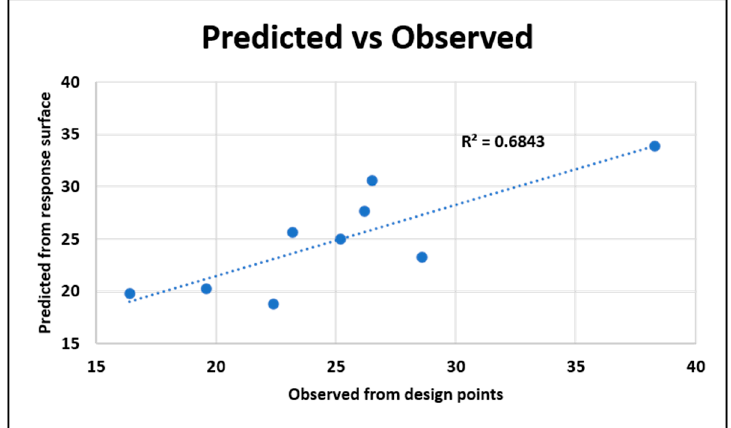
Figure 21. Goodness of fit for the improved system from the dielectric response.